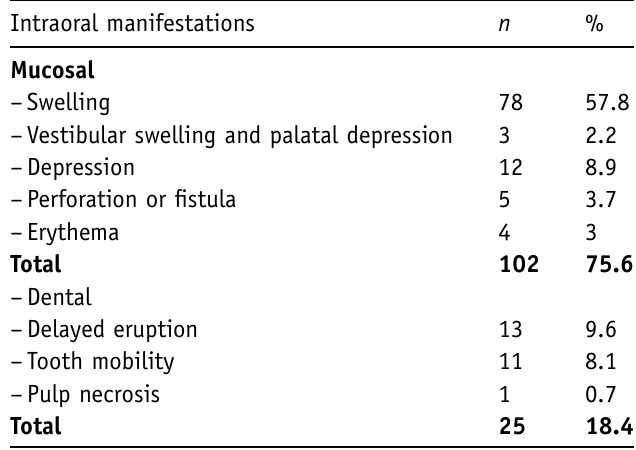
Table II. Intraoral clinical features of central odontogenic fi broma.